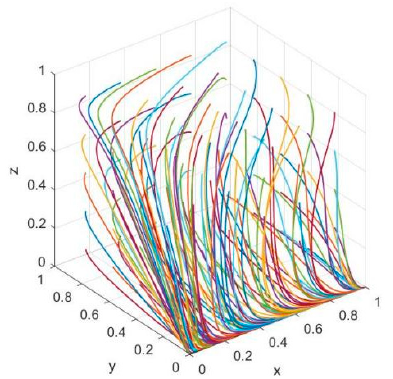
Figure 2. Evolutionary simulation at the initial stage point (1, 0, 0).